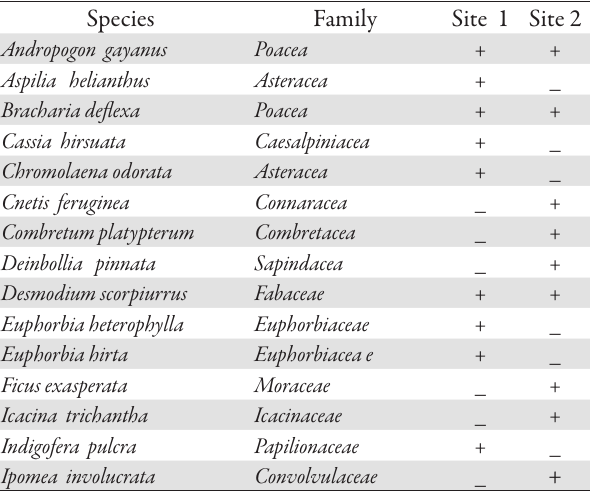
Tab. 1. Plant species composition of the standing vegetation of the study